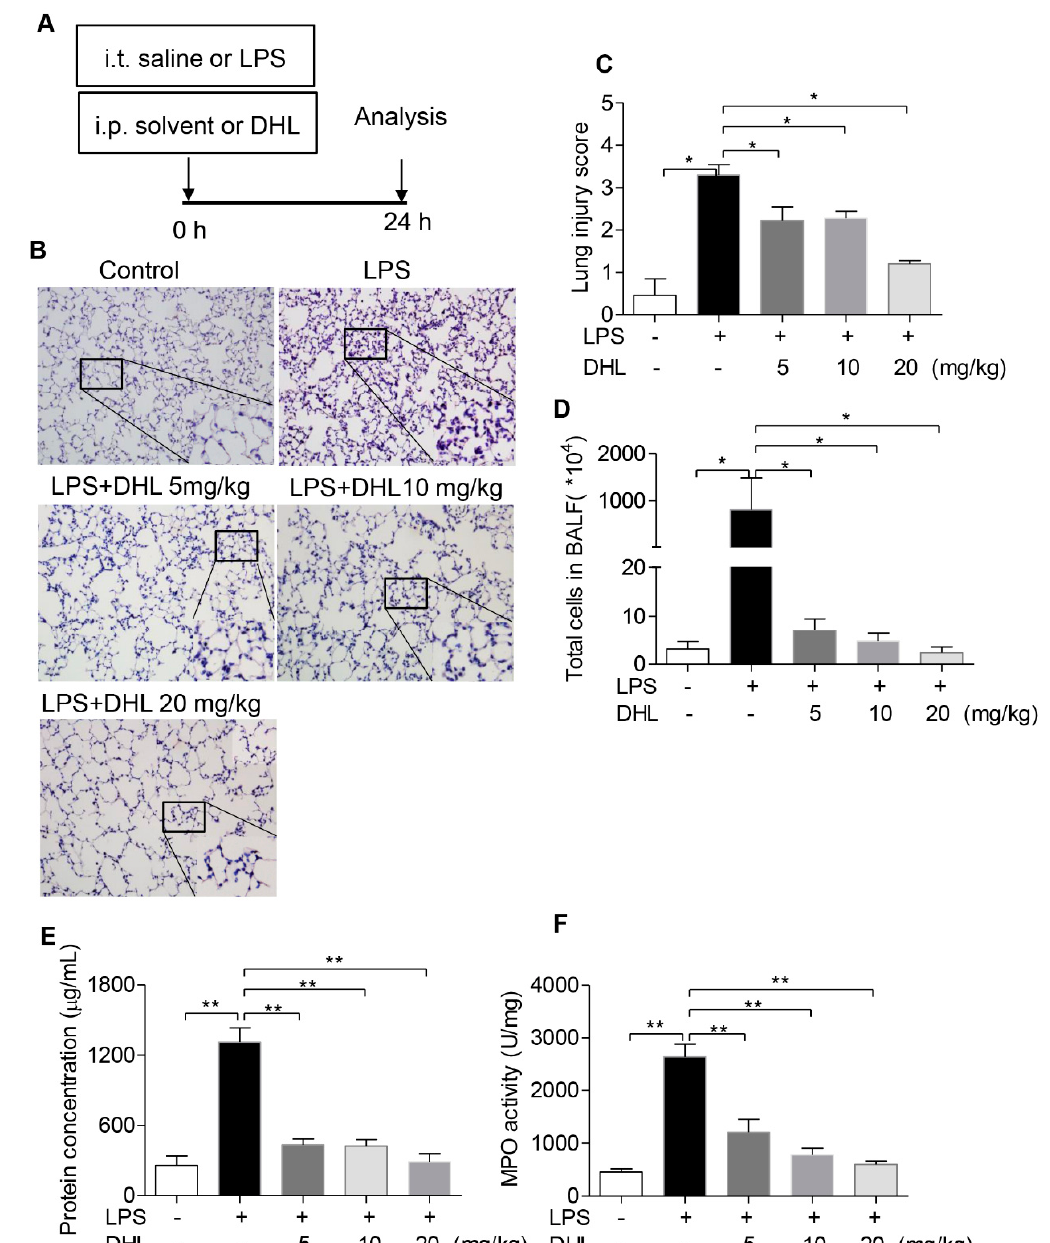
Figure 6. DHL attenuated LPS-induced acute lung injury in vivo. ( A ) Mice were subjected to an intratracheal injection of LPS (5 mg/kg) and subsequent intraperitoneal injection of solvent or DHL (5, 10 and 20 mg/kg respectively), ( B ) Histological analysis of lung tissue sections by H&E staining. The original magnification was 200×, and detailed images are shown in lower right corner. ( C ) Lung tissue injury was assessed by histological scores in all groups. ( D ) The total cell count in BALF after red blood cell lysis. ( E ) Measurement of the total protein concentration of BALF. ( F ) Determination of the myeloperoxidase (MPO) activity in lung homogenates. Data represent means ± SEM, n = 6–8, * p < 0.05 and ** p < 0.01.